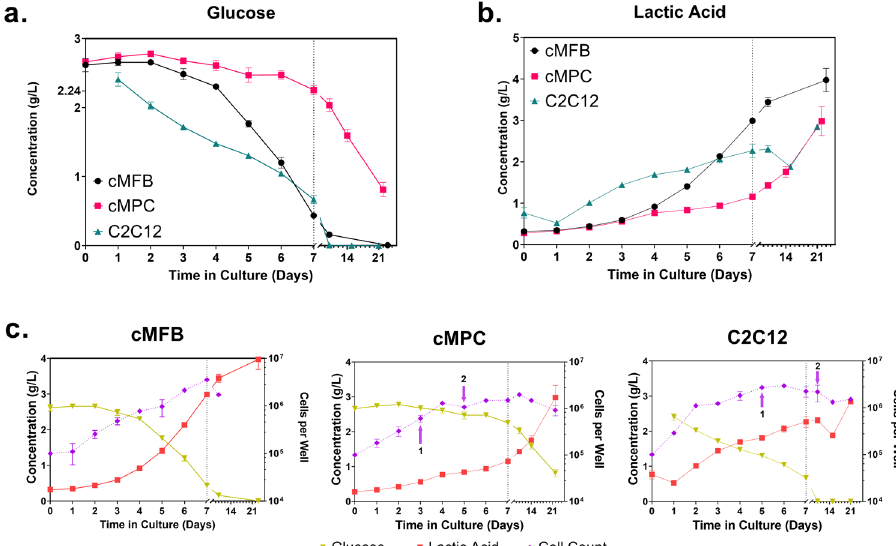
Fig. 1 Glucose and LA + cell count. Analysis of sugars and organic acids in spent media from cultures of three different cultivated meat- relevant cell types. The three cell types were plated at 100,000 cells per well in 6-well plates, and the media from three wells per cell type were collected at each predetermined time point for chemical analysis. The concentrations of glucose ( a ) and lactic acid ( b ) in the spent media samples are plotted separately with each cell type ’ s trends overlaid. c The same data for the three cell types are each plotted separately with glucose and lactic acid concentrations overlaid. Cell counts per well in the 6-well plate experimental setup are overlaid in purple. Arrows pointing at cell count data points indicate differentiation status, with (1) indicating the time at which fi rst signs of differentiation were apparent, and (2) indicating the time the maximum differentiation was reached. Data points represent the mean of three biological replicates ± standard deviation. cMFB, primary embryonic chicken muscle fi broblasts. cMPC, primary embryonic chicken muscle precursor cells. C2C12, murine myoblast-like cell line. The expected concentration of glucose in fresh media (40% high glucose DMEM, 40% Ham ’ s F10) is indicated in a at 2.24 g/L and is based on the manufacturer ’ s formulation sheet but does not include the contribution from the 20% fetal bovine serum in the experimental medium. Vertical dotted lines highlight the break in the x -axis scales at day 7 in c